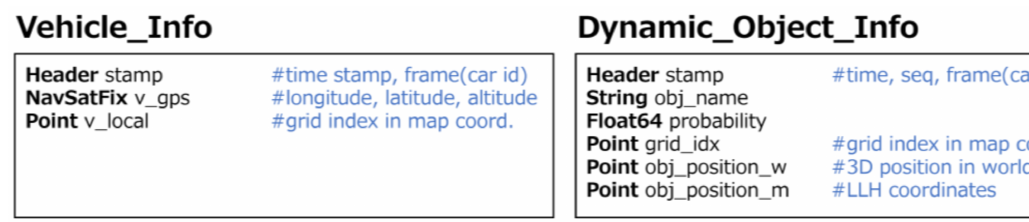
Figure 4. Coordinate systems and grid setting.